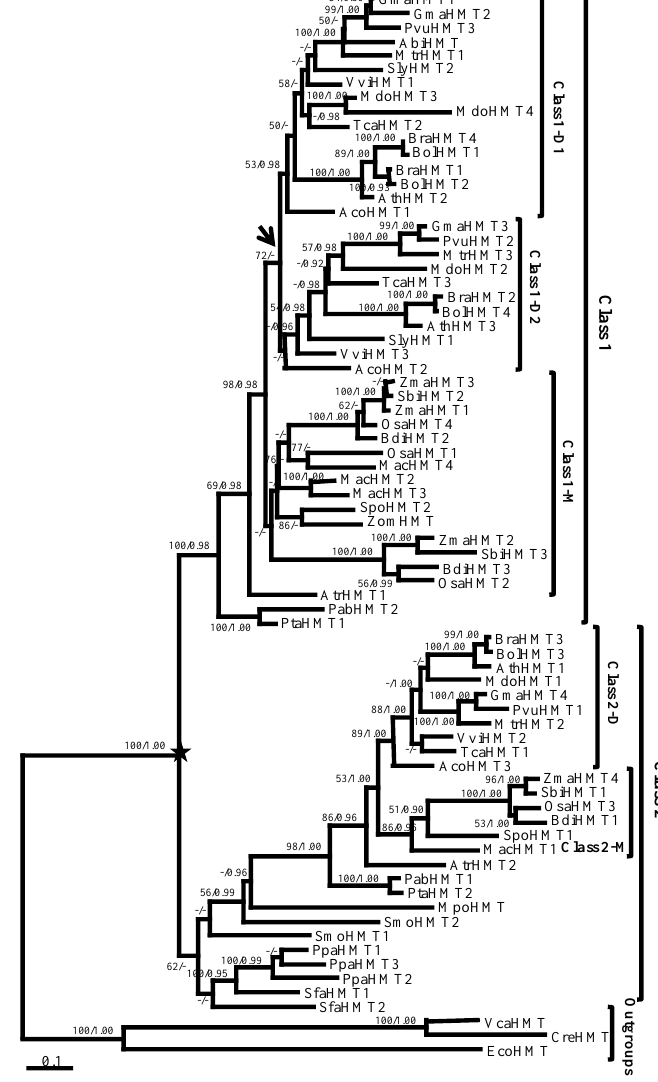
0 . 1 Figure 1. Phylogenetic tree of the homocysteine methyltransferase ( HMT) gene family in plants. The tree was constructed with ML and Bayesian methods based on the amino acid (aa) sequences with EcoHMT, CreHMT, and VcaHMT as outgroups. Support values (>50% of ML) and posterior probabilities (>0.9 of Bayesian) for this tree are shown on respective branches. The black star indicates the divergence of Class 1 and Class 2, and the arrow indicates the divergence of Class 1-D1 and Class 1-D2. Gene names and identifiers are shown in Table S1 in Additional file